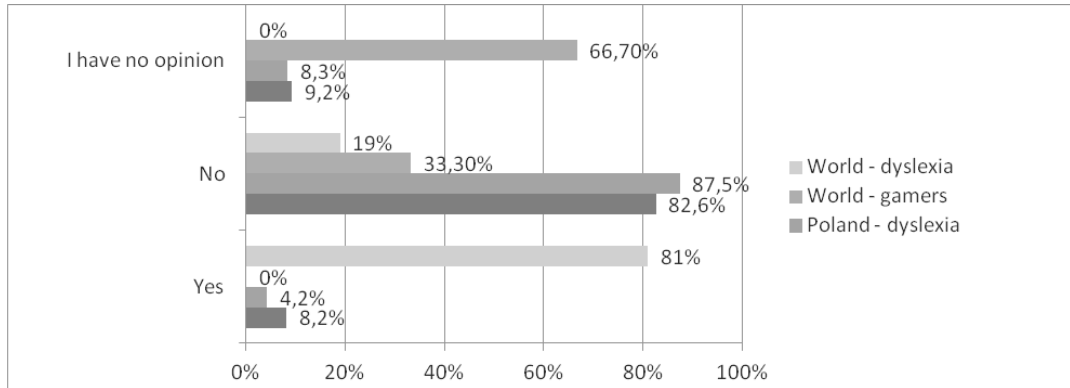
Figure 2. (cid:53)(cid:72)(cid:77)(cid:72)(cid:70)(cid:87)(cid:76)(cid:82)(cid:81)(cid:3)(cid:69)(cid:92)(cid:3)(cid:87)(cid:75)(cid:72)(cid:3)(cid:73)(cid:68)(cid:80)(cid:76)(cid:79)(cid:92)